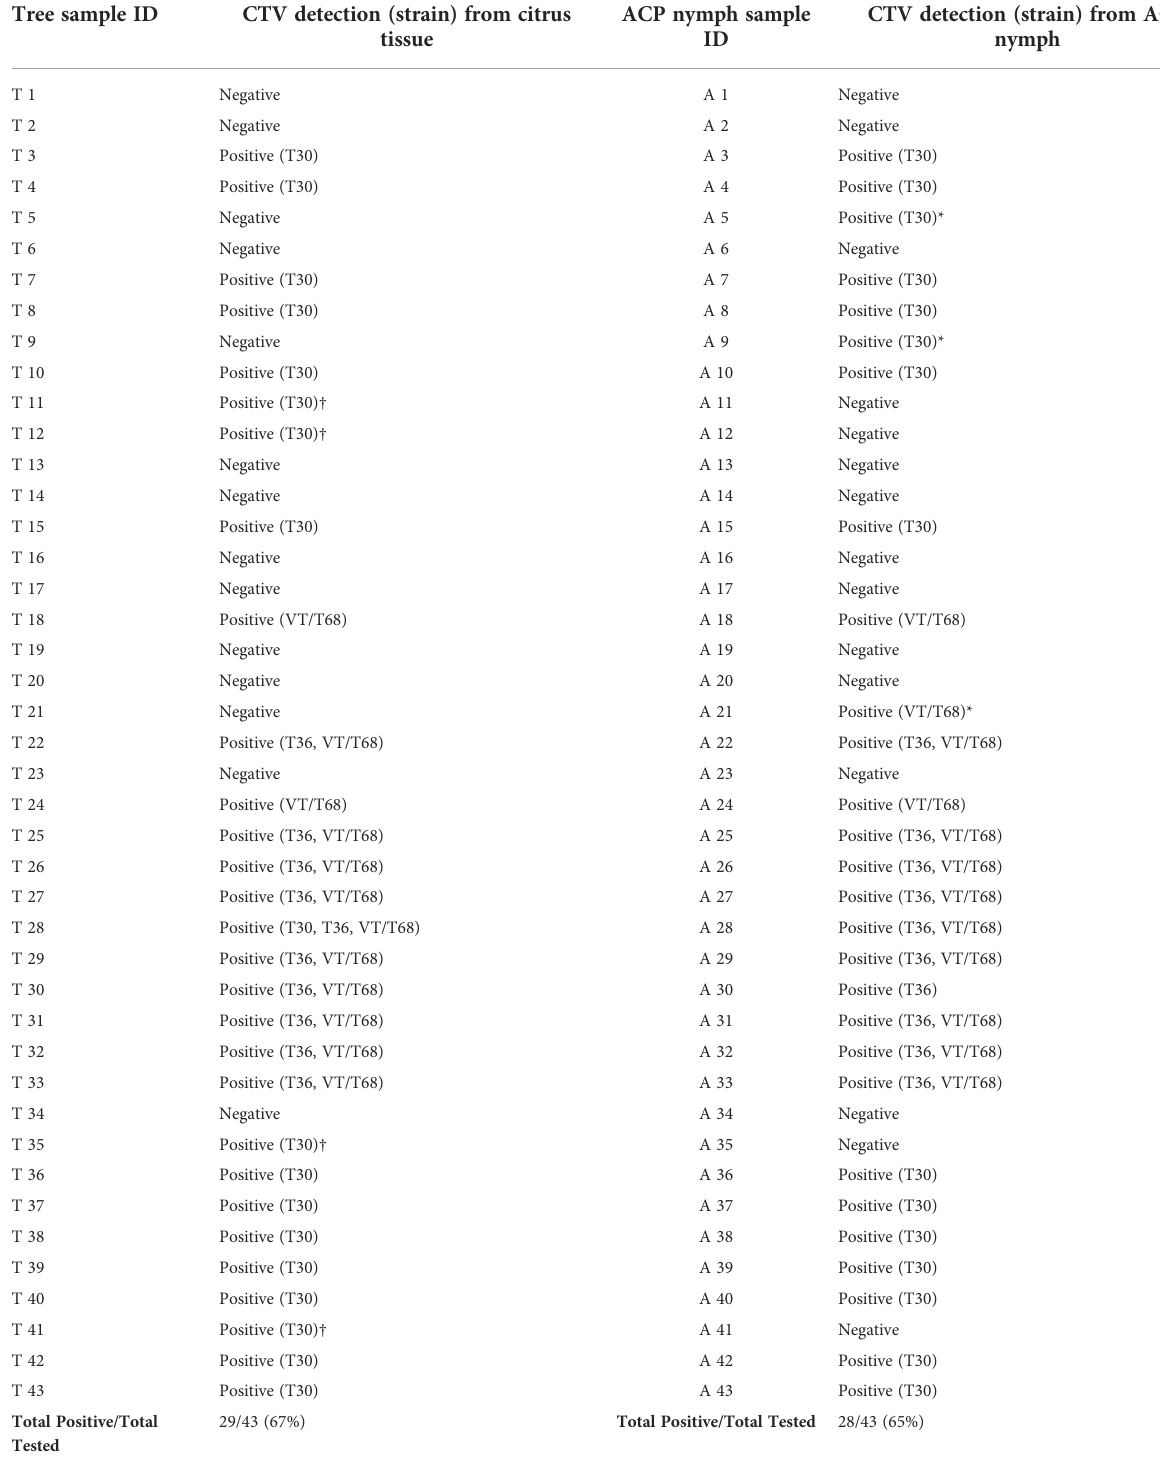
TABLE 5 Citrus tristeza virus (CTV) and strain detection in citrus tissue or Asian citrus psyllid ( Diaphorina citri ; ACP) nymph tissue during comparative study. Tree sample